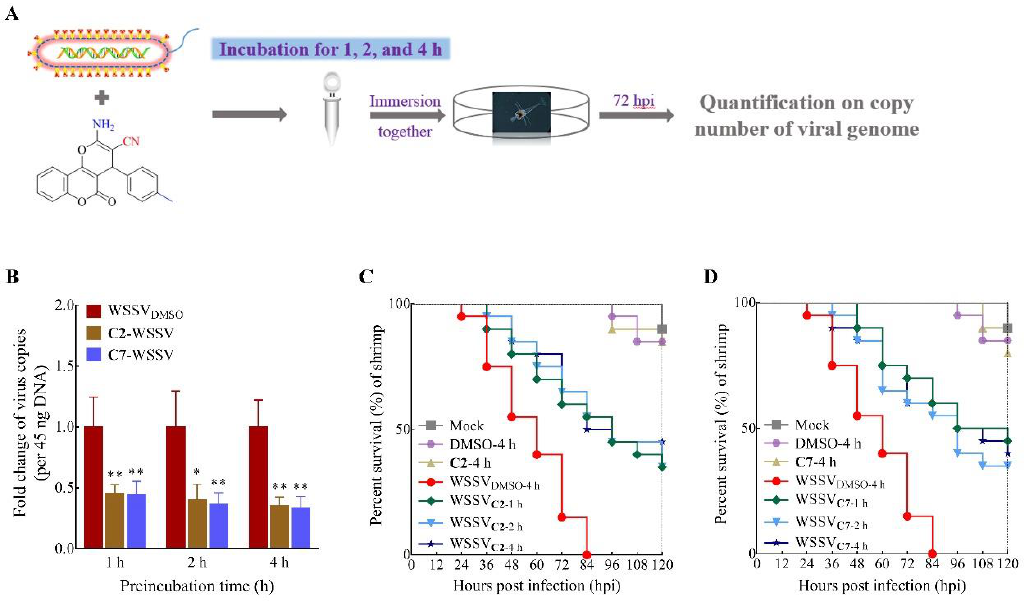
Figure 4. Antiviral activity of C2 and C7 was evaluated on preincubation with WSSV. ( A ) Schematic diagram describing the workflow. ( B ) Quantification on copy number of viral genome in shrimp larvae was tested in C2 and C7 preincubation with WSSV for 1, 2, and 4 h, followed by infection to larvae. ( C , D ) Survivorship curve of WSSV-infected shrimp was analyzed in C2 and C7 at the concentration of 10 mg/L in 1, 2, and 4 h preincubation. Each value is represented as the mean ± SD normalized to values for no treatment. The p value for each study was determined by Student’s t tests. ** p < 0.01; * p < 0.05.